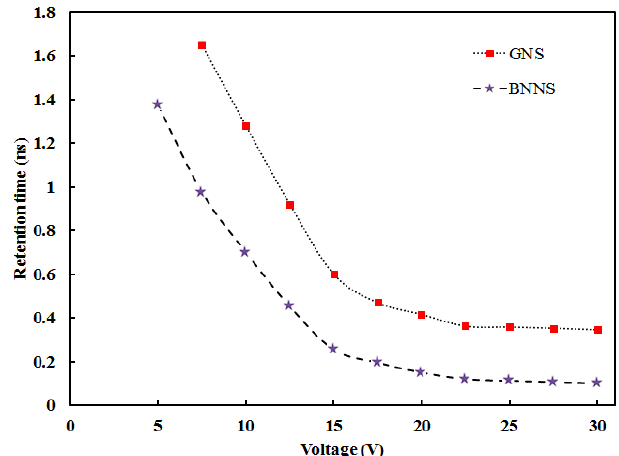
Fig. 5: Retention time for Ni 2+ in various voltages in the GNS and BNNS. Figure 5. Retention time for Ni 2+ in various voltages in the GNS and BNNS.